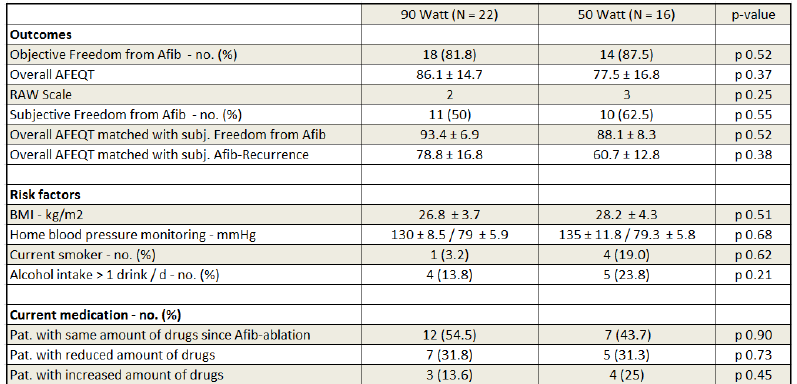
Figure 4. Long-term follow-up data.